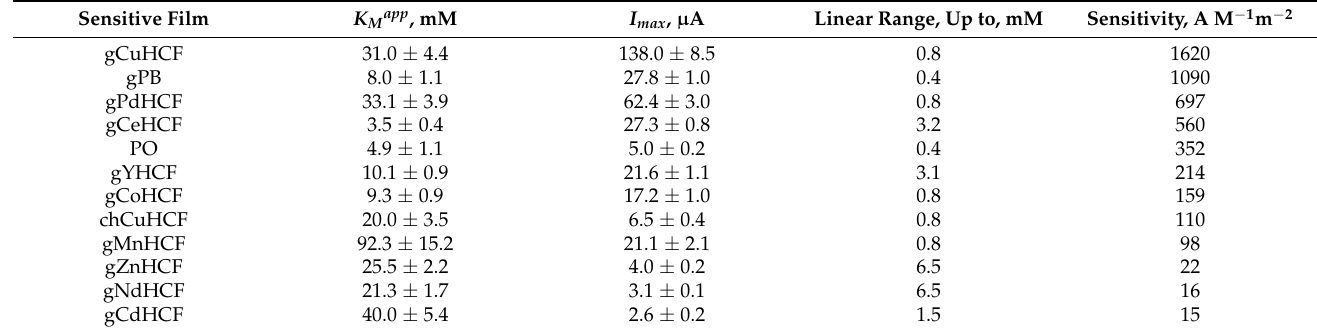
Table 1. Comparative analytical characteristics of HCFs as artificial peroxidases on graphite electrodes. Sensitive